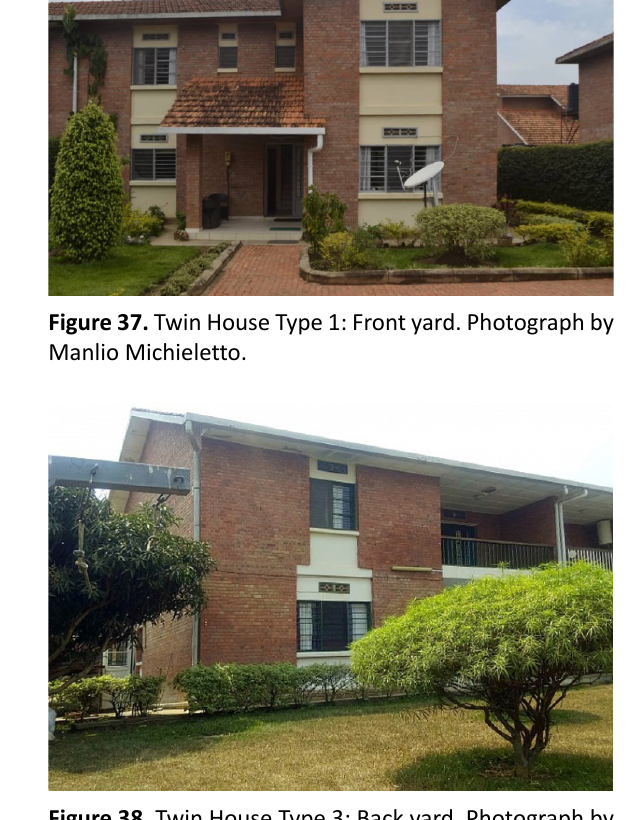
Figure 35. Twin House Type 4: Front yard. Photograph by Manlio Michieletto.